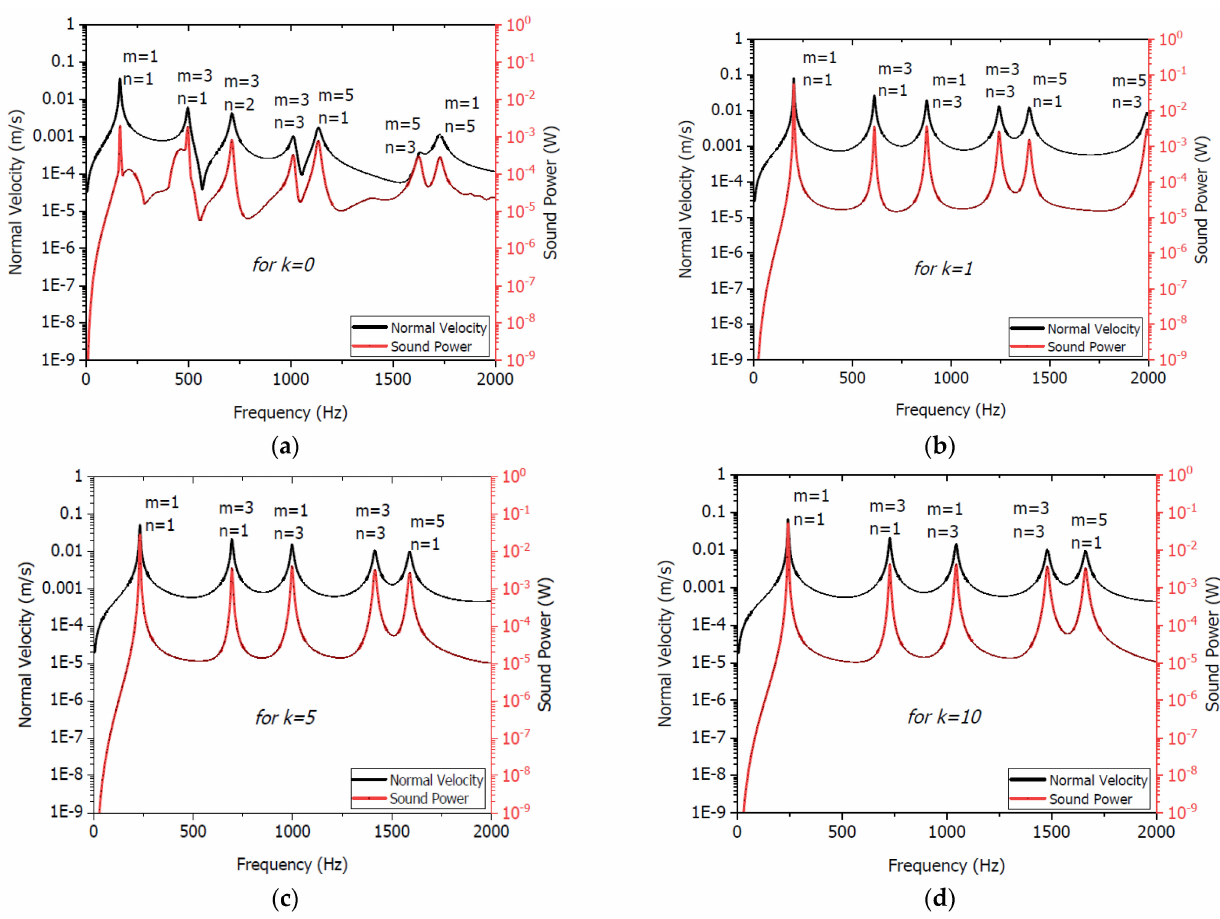
Figure 7. Illustration of SPL and V_rms of P-FGM plates on a single plot for power-law indexes k = ( a ) 0, ( b ) 1, ( c ) 5, and ( d )